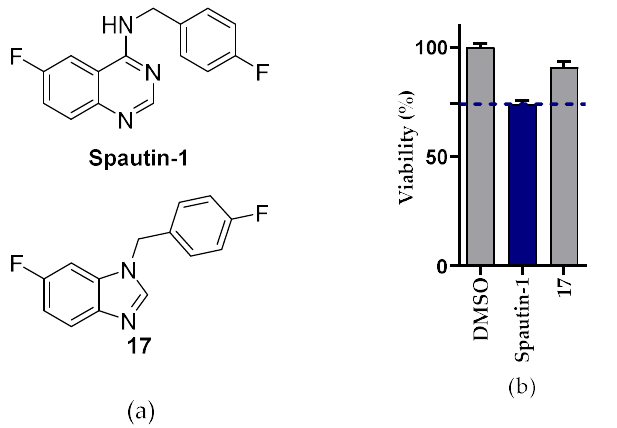
Figure 12. ( a ) Spautin-1 analogue 17 bearing the benzimidazole core; ( b ) viability assay (5µM) with Spautin-1 as reference.